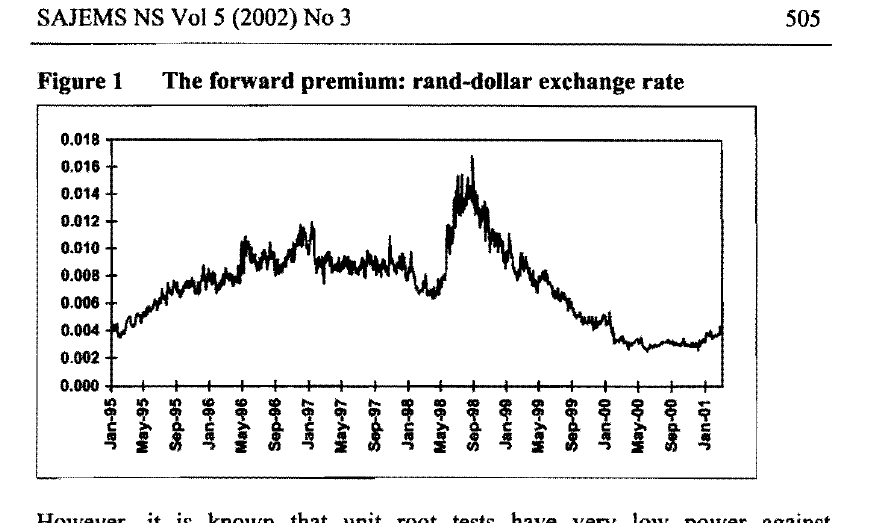
The forward premium: rand-dollar exchange rate